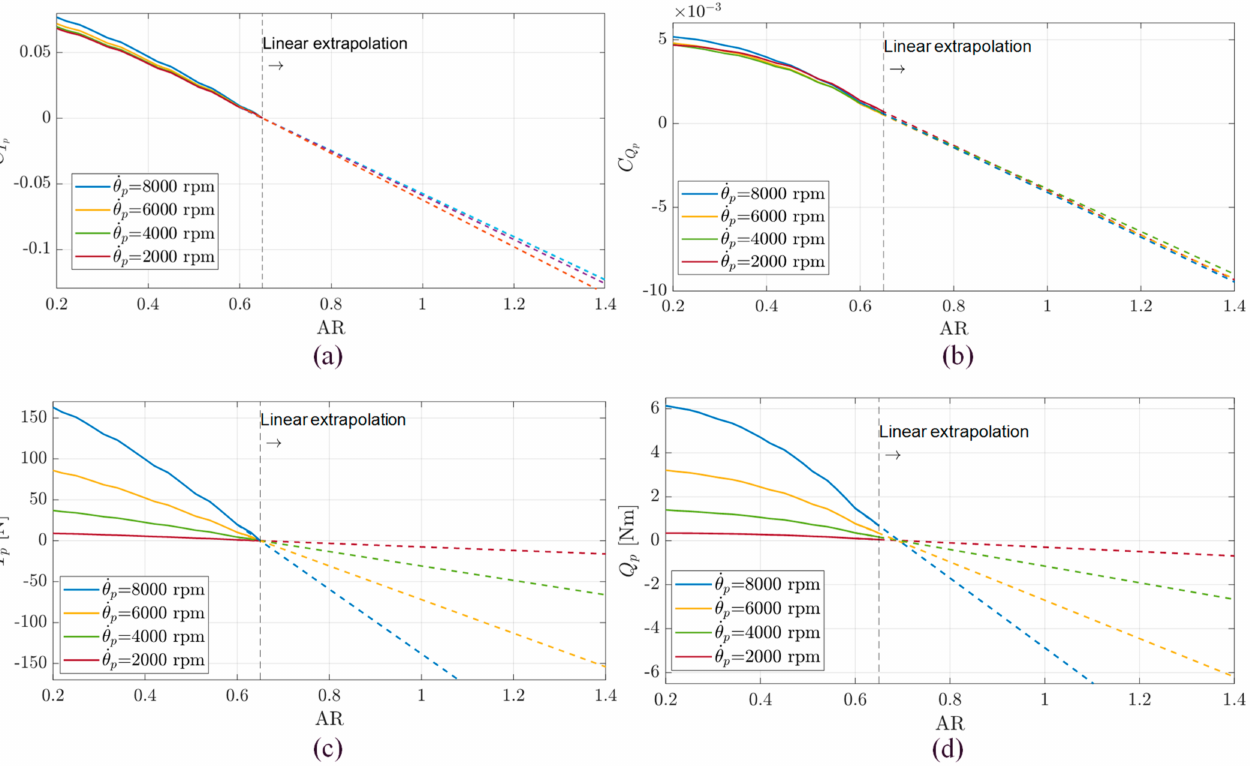
Figure 5. APC 22 × 10E propeller curves: thrust coefficient ( a ) and torque coefficient ( b ), thrust ( c ) and torque ( d ) at sea